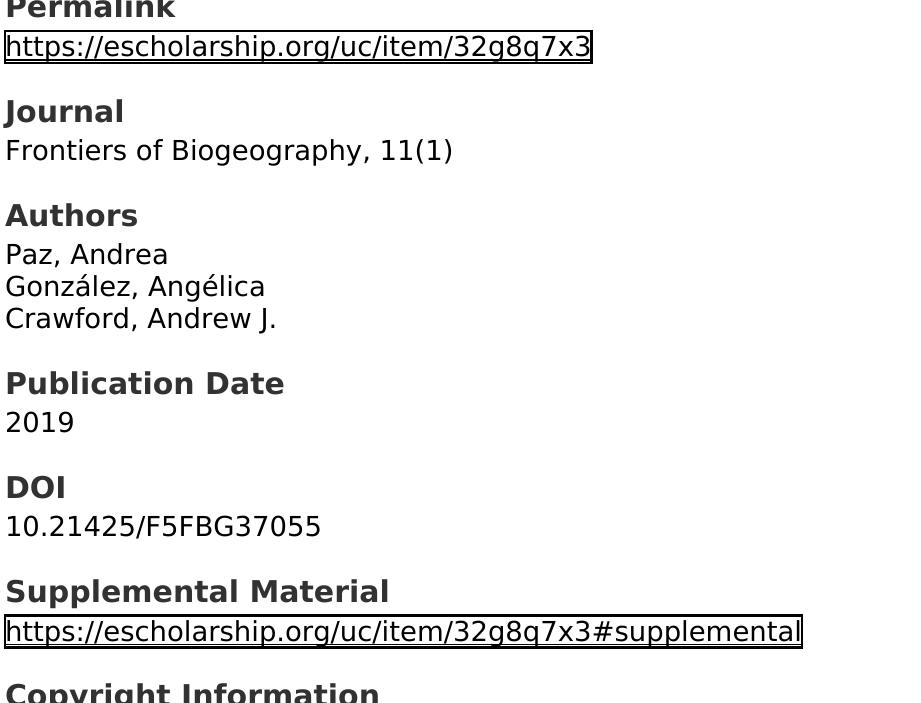
Testing effects of Pleistocene climate change on the altitudinal and horizontal distributions of frogs from the Colombian Andes: a species distribution